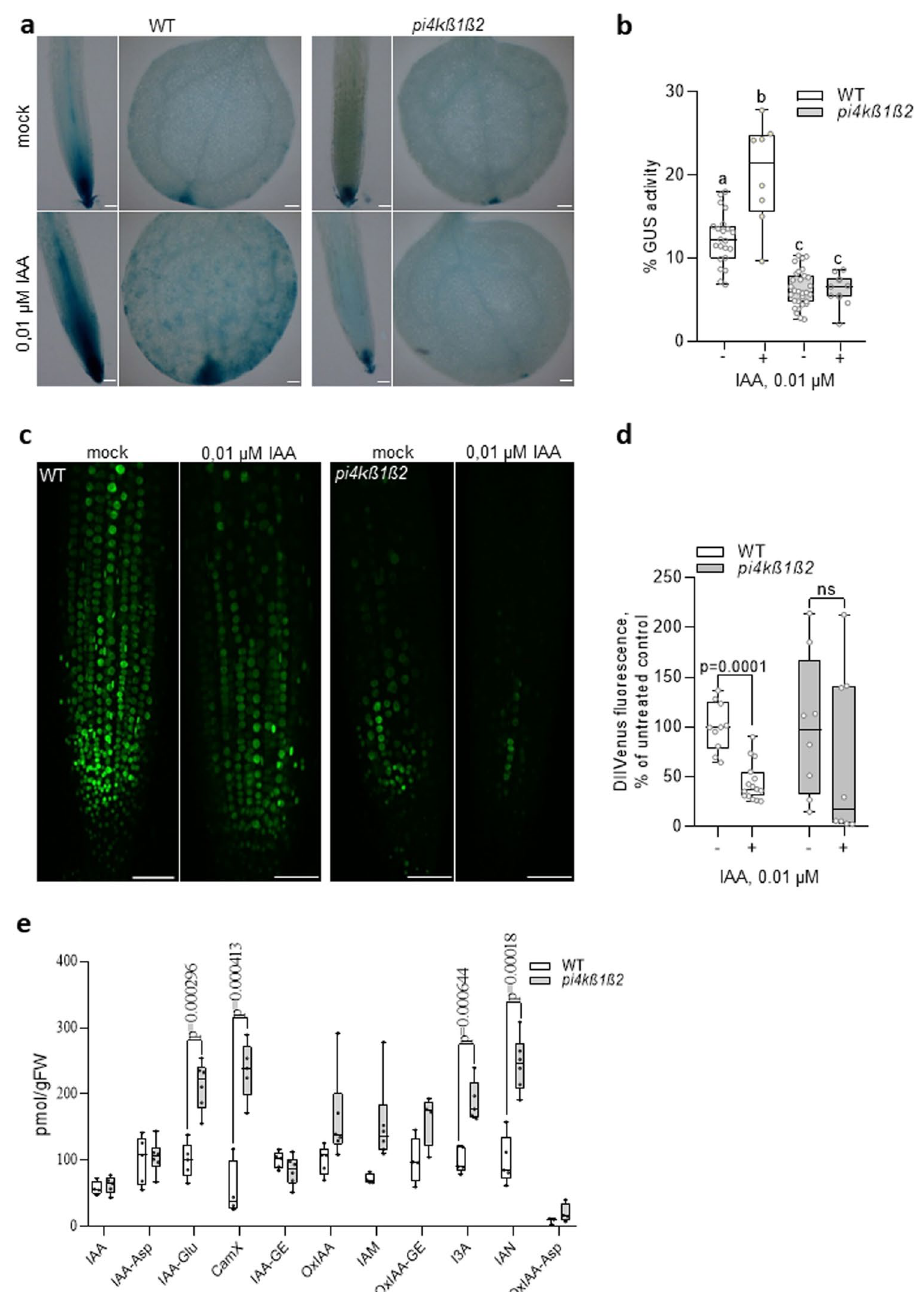
Figure 4. Auxin sensitivity of the pi4kß1ß2 mutant. ( a ) representative images of DR5-GUS activity in 5-day- old root and cotyledons in the presence or not of 0.01 µM IAA for 12 h, scale bar = 100 µm; ( b ) DR5-GUS quantification, % of GUS-stained area in root meristem, n = 10; ( c ) representative images of DII-VENUS fluorescence in root tip of 7-day-old seedlings in the presence or not of 0.01 µM IAA for 1 h, maximum intensity Z-projections of 10 nm stacks, scale bar = 50 µm; ( d ) DII-VENUS fluorescence quantification, % of meristematic zone; n = 10; ( e ) quantitation of IAA metabolites and conjugates in 7-day-old roots, n = 6; Central line of the boxplots represents the median, circles represent individual values; p -value is indicated for significantly different groups, ns – non significant; unpaired t -test ( d,e ); The data are presented in means ± SD, n = 10, with a Tukey honestly significant difference (HSD) multiple mean comparison post hoc test. Different letters indicate a significant difference (one-way ANOVA, Tukey HSD, P < 0.05) ( b ); Experiments were repeated three times; data from a representative repeat are shown. IAA = indole-3-acetic acid, IAA-Asp = IAA-aspartate, IAA-Glu = IAA- glutamate, CamX = camalexin, IAA-GE = IAA-glucose ester, OxIAA = oxo-IAA, IAM = Indole-3-acetamide (IAA precursor), OxIAA-GE = oxo-IAA-glucose ester, I3A = indole-3-aldehyde, IAN = Indole-3-acetonitrile (IAA precursor), OxIAA-Asp =